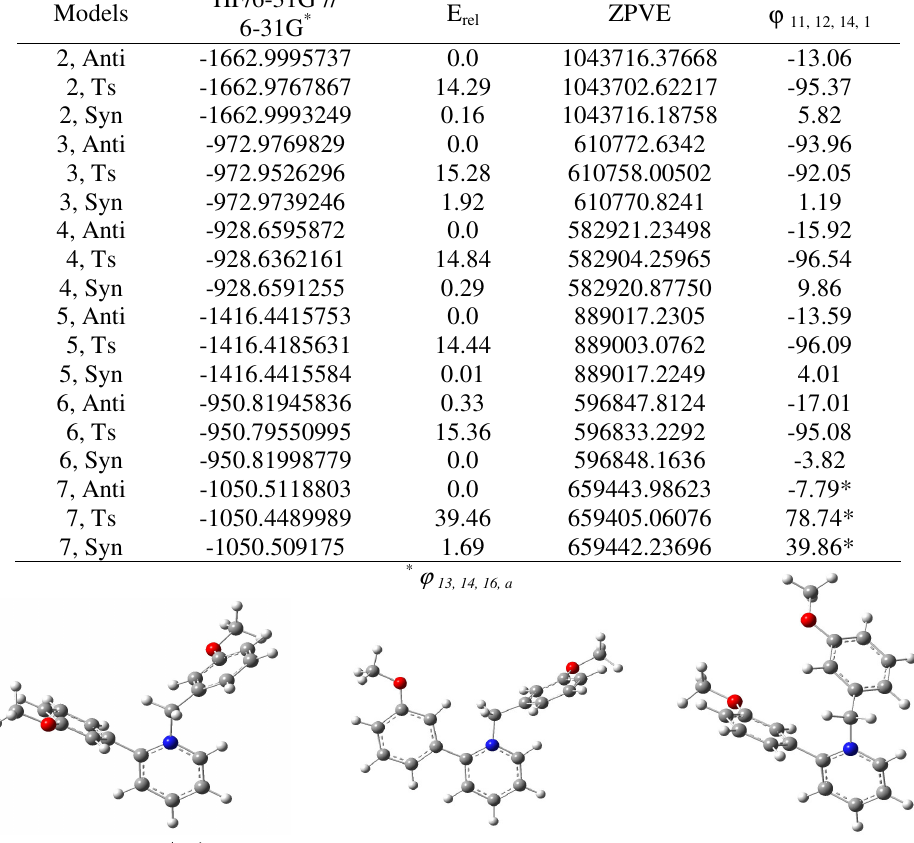
for conformers of models 2-7. 11,12,14,15 11, 12, 14, 1